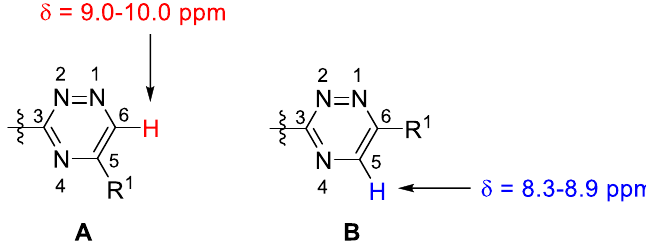
Figure 1. Differentiation of 3,5- and 3,6-disubstituted 1,2,4-triazine isomers by the chemical shift ranges of the H-6/H-5 signals.